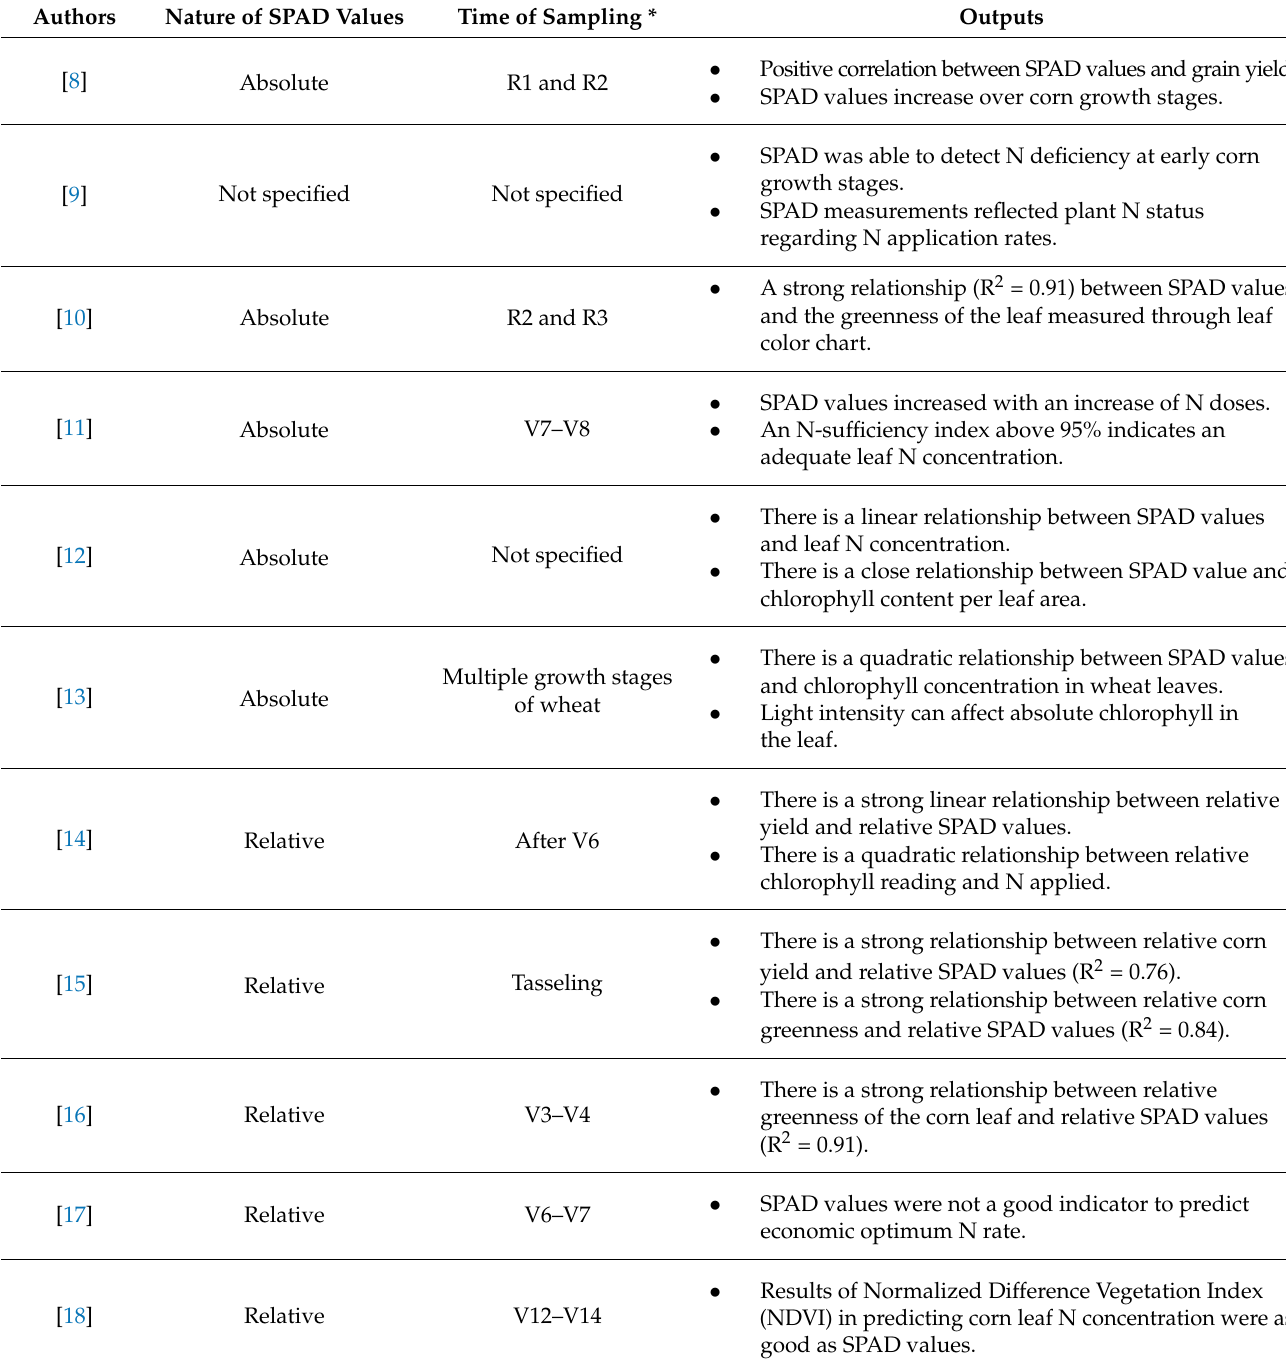
Table 1. Use of the soil–plant analysis development (SPAD) meter for corn N management (recapitulative from several authors). Authors Nature of SPAD